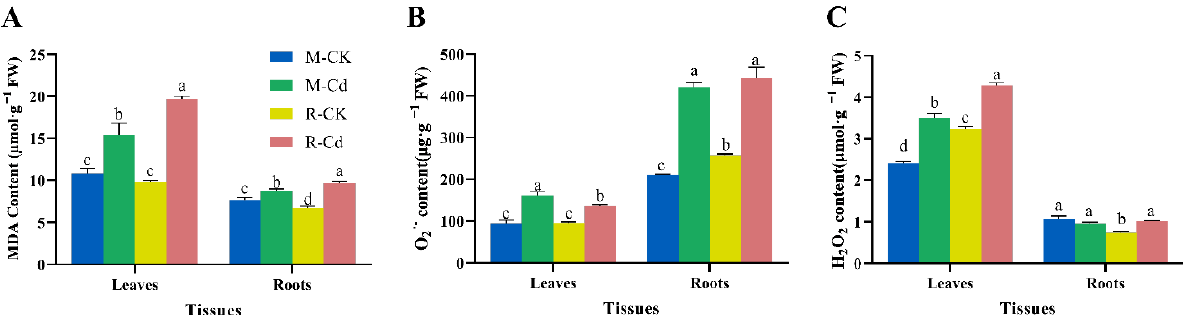
Figure 3. Effects of Cd stress on MDA ( A ), H 2 O 2 ( B ), and O 2 − ( C ) content in the leaves and roots of M and R genotypes. The significant differences between M and R genotype were based on one-way ANOVA. The different letters indicate that the difference is significant at a 0.05 level. Data were shown by “means ± SE”. CK and Cd represent treatments of 0 and 1000 μM Cd, respectively.